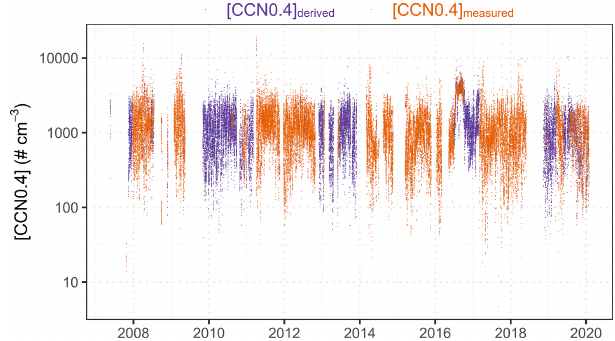
Figure 2. Hourly [CCN0.4] measurements at Lamont, Oklahoma, from 2007 to 2020. The orange circles show the data for [CCN0.4] measured here. The purple circles show the data for [CCN0.4] de- rived from [CCN0.2–0.6] according to the method described in Sect. 2.4.2.